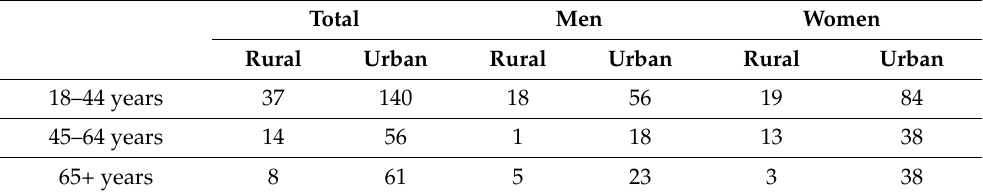
Table 2. Demographic characteristics and living environment of the participants.